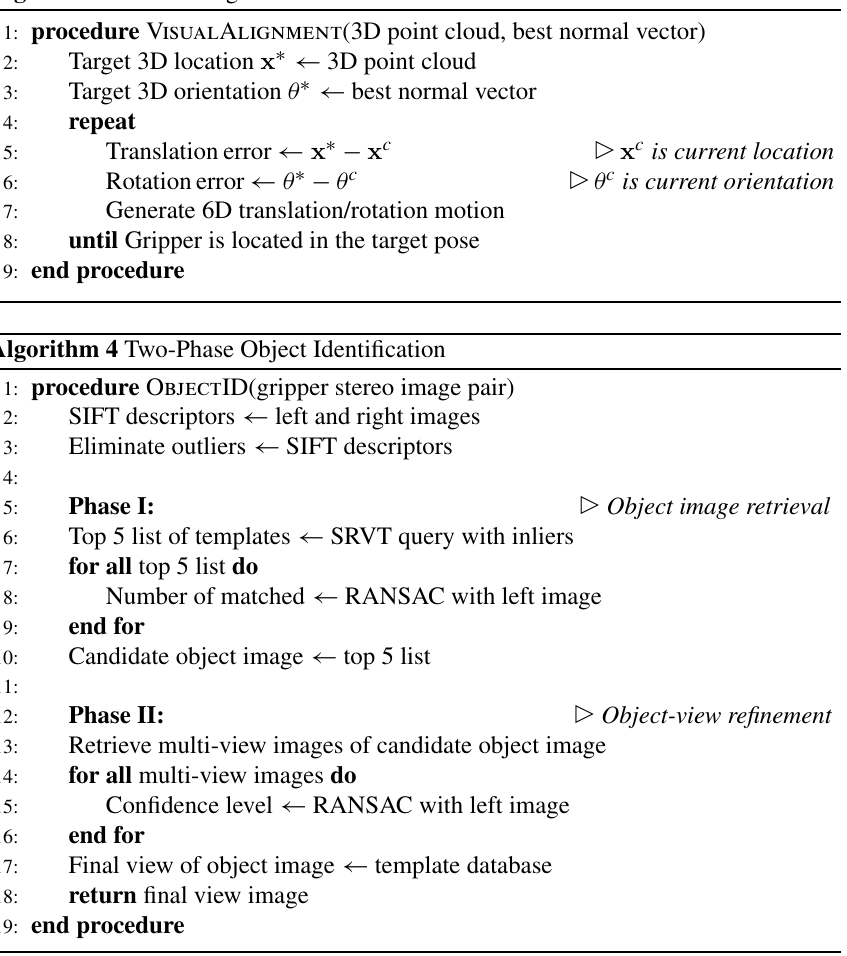
Algorithm 3 Visual Alignment